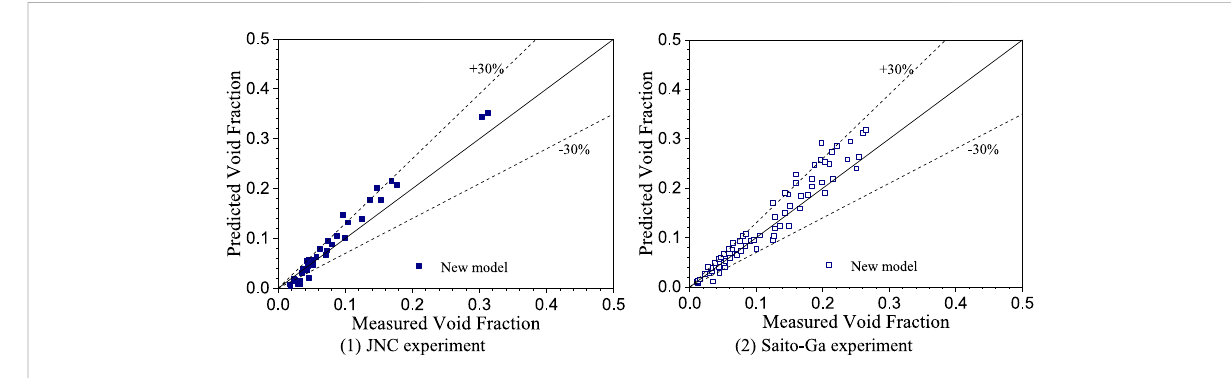
FIGURE 13 Comparisons between measured and predicted void fraction. (A) JNC experiment. (B) Saito-Ga experiment.